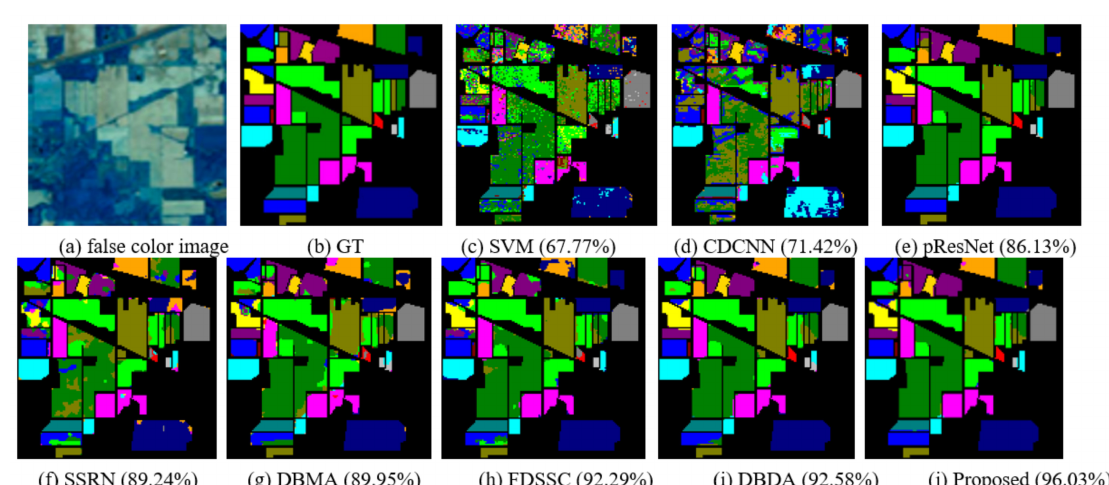
Figure 7. Classification maps of IN data set using 3% training samples: ( a ) false color image, ( b ) ground truth map (GT) and ( c – j ) the classification map and overall accuracy of different